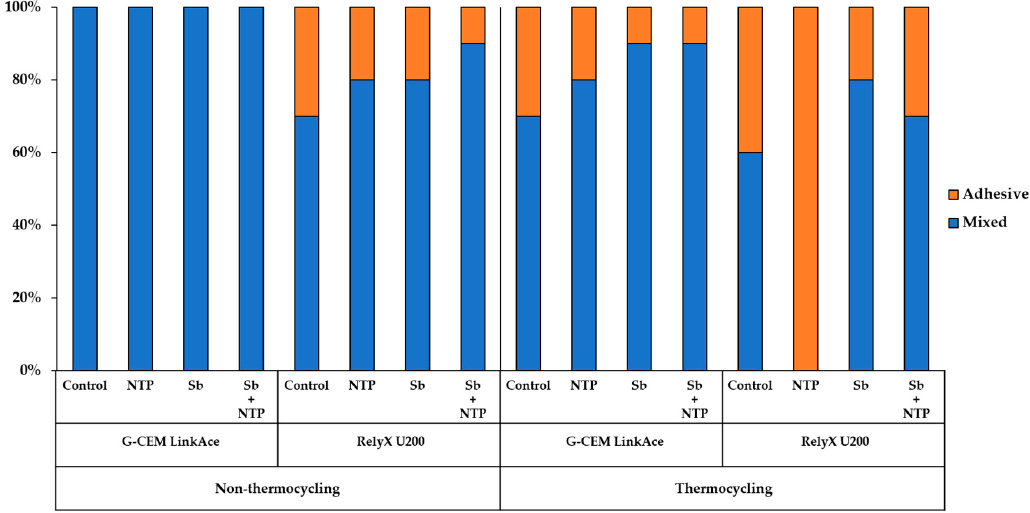
Figure 8. Failure mode distribution of the Y-TZP for each group after the SBS test.